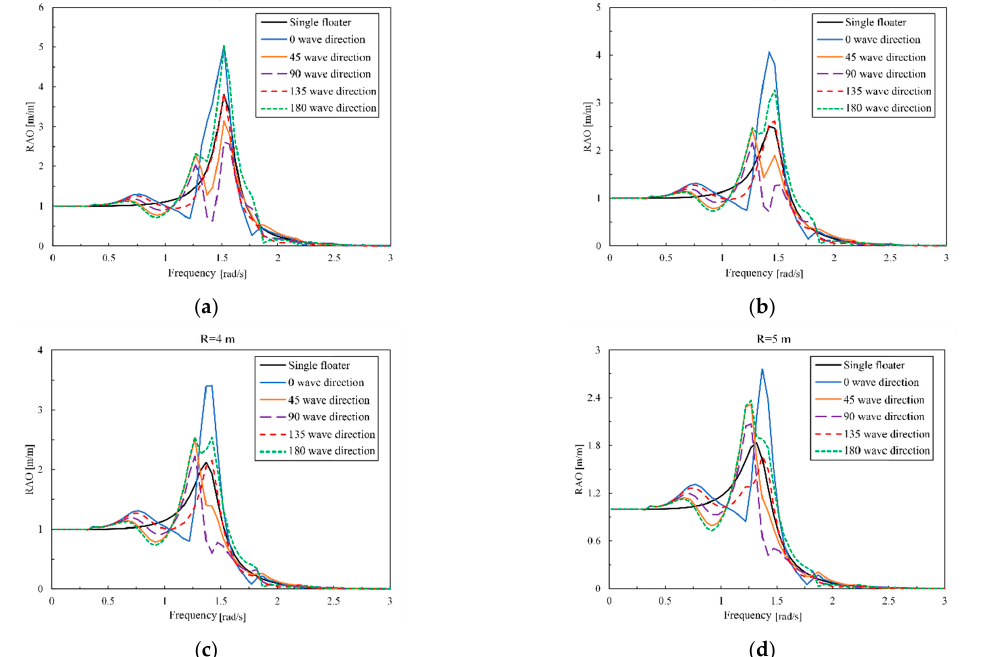
Figure 5. Comparison of RAO with different waves floater: ( a ) R = 2 m; ( b ) R = 3 m; ( c ) R = 4 m; ( d ) R = 5 m.